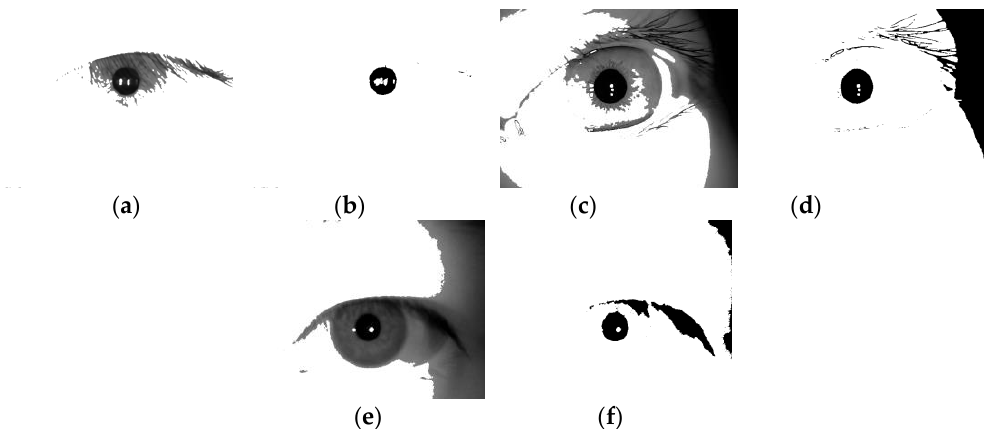
Figure 8. The eye discrimination image. ( a ) Eye discrimination image collected by the device in Figure 2b, ( b ) the image of Figure 2a corresponds to the binarized image of the pupil, ( c ) eye discrimination image collected by the device of Figure 2d, ( d ) the image of Figure 8c corresponds to the binarized image of the pupil, ( e ) eye discrimination image collected by the device of Figure 2f, ( f ) the image of Figure 8e corresponds to the binarized image of the pupil.